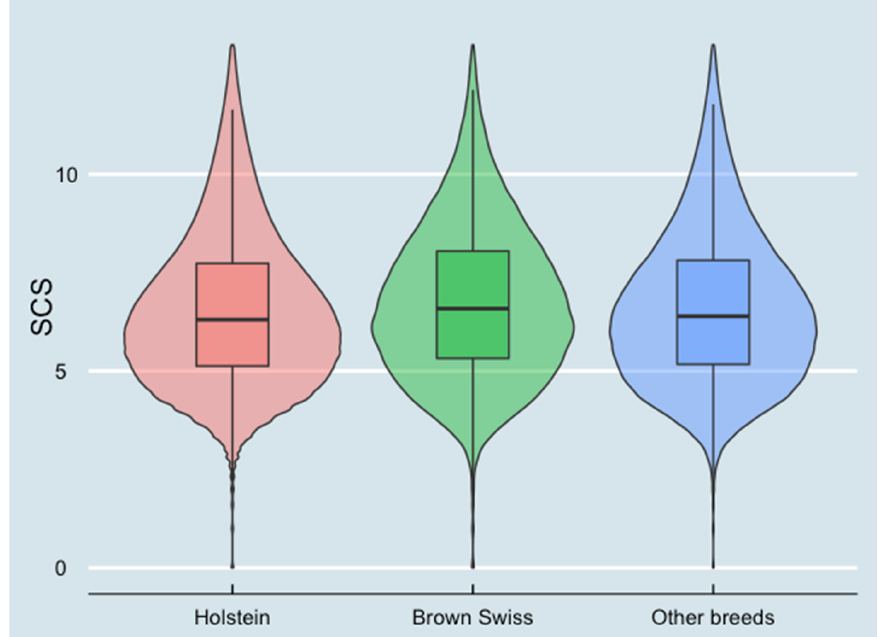
Figure 4. Somatic cell score (SCS) at test-day records level in different breed groups (10,445,464 test- day records from 826,831 cows in 2970 herds). The violin plot combines the probability density (area under the curve) and box plots.